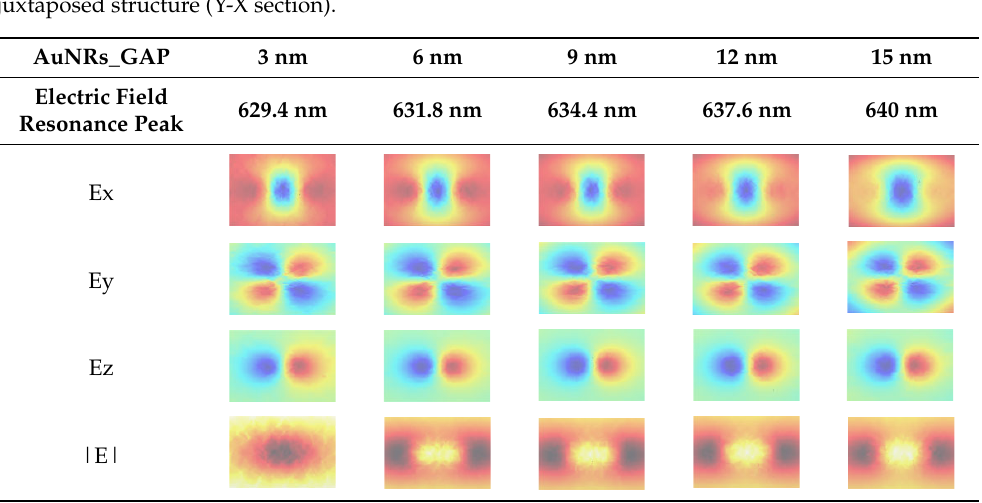
Table 2. Electric field distribution under the resonance peak of the gold nanorod dimer in the juxtaposed structure (Y-X section).